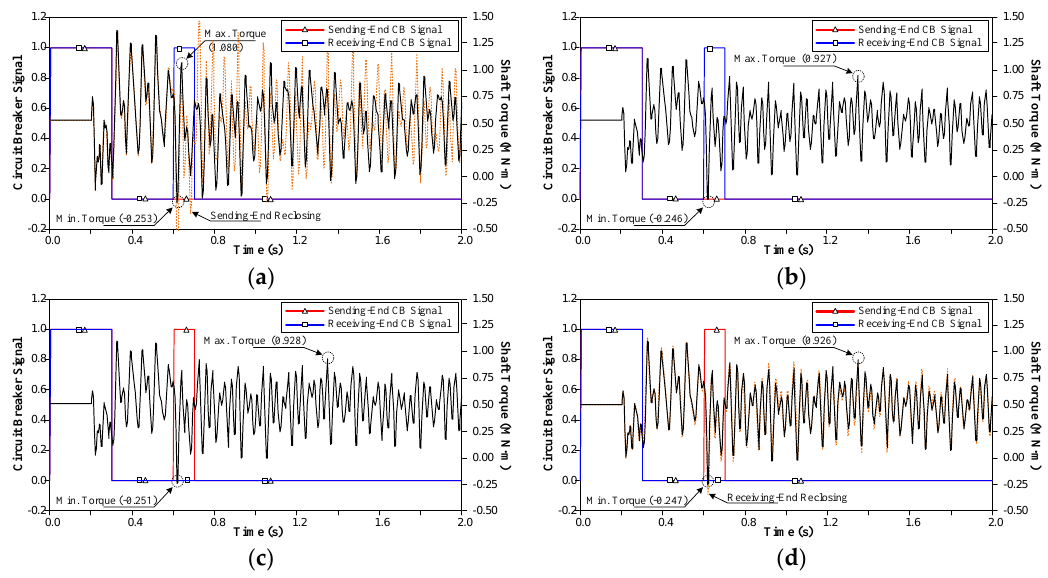
Figure 7. Circuit breaker operation signal and instantaneous shaft torque waveform: ( a ) for case 5-1 (10% of T/L #3); ( b ) for case 5-2 (83% of T/L #3); ( c ) for case 5-3 (84% of T/L #3); ( d ) for case 5-4 (90% of T/L #3).